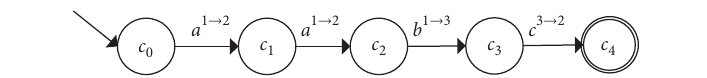
Figure 4: The synchronous interaction behavior of the microservice system shown in Figure